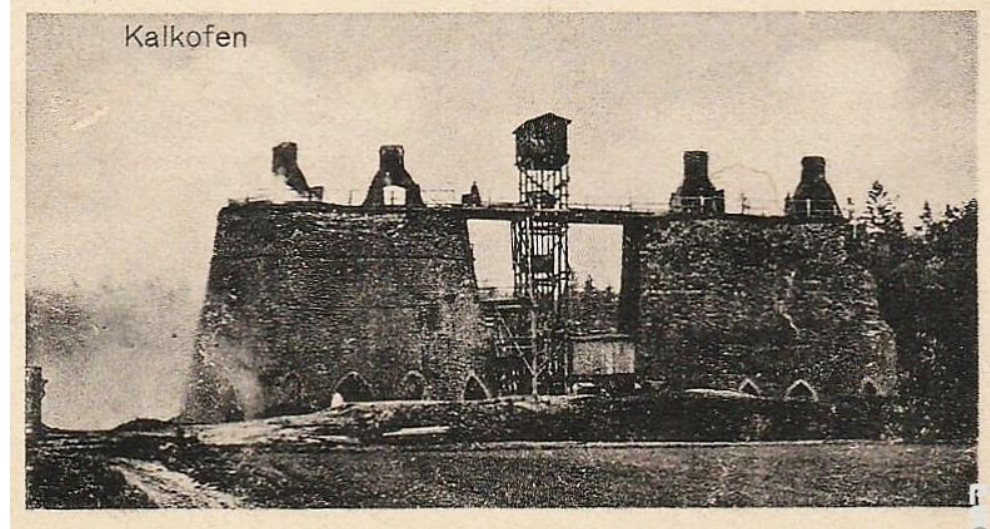
Fig. 5. The already non-existent lime kilns in Mokre – a fragment of a postcard from the 1940s (Source: